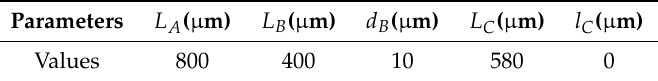
Table 4. The parameters of the lever coupling mechanism.